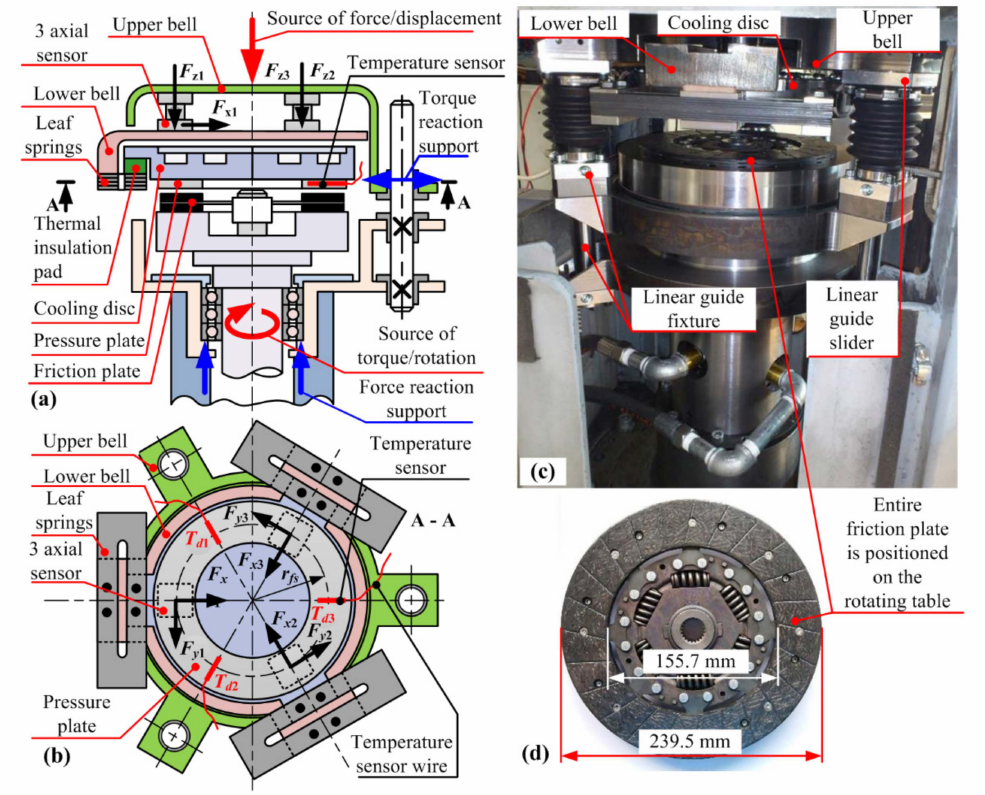
Figure 1. Functional schematics ( a , b ) and photographs of the redesigned disc-on-disc tribometer rig ( c ) and friction plate ( d